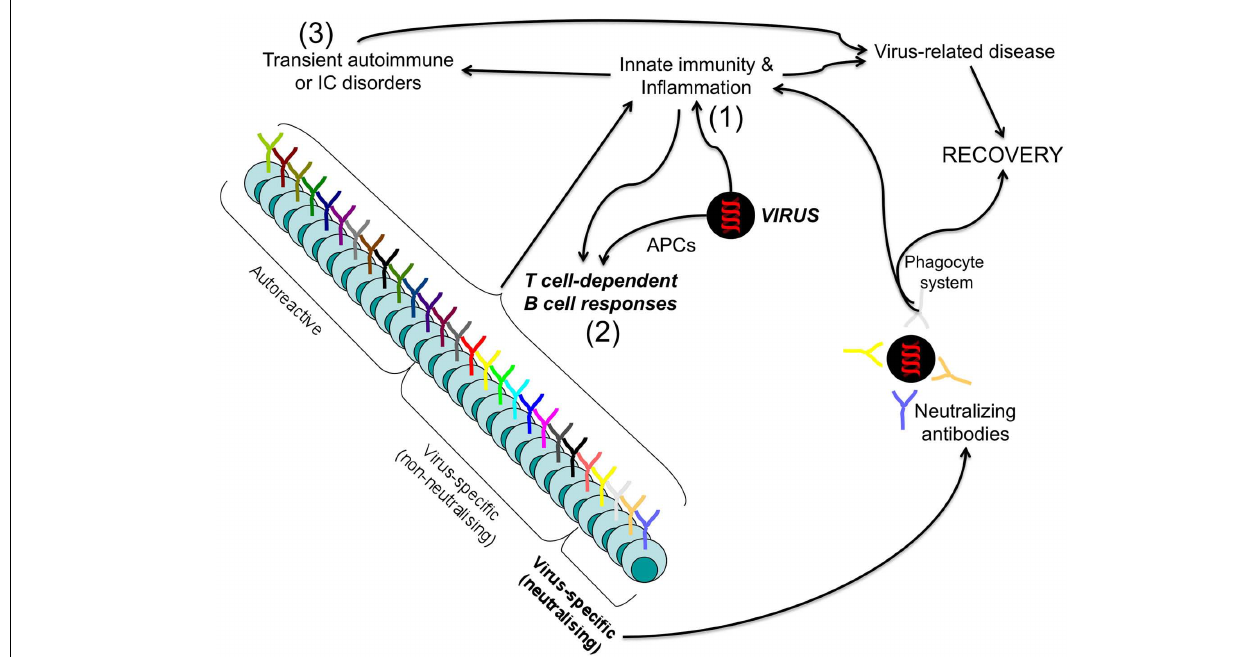
immune complexes (ICs) and produce damage through the cooperation with the innate immune system (macrophages, complement factors, inflammatory cytokines ... ) (3). However, neutralizing, non-neutralizing virus-specific B cells, as well as the autoreactive, act in concert to fight the pathogen: the neutralizing in an antigen-specific manner, the non-neutralizing and autoreactive in a bystander manner via the activation of the phagocytic system by ICs resulting in the amplification of the inflammatory responses (acute disease).This inflammatory storm is self-limited, when the pathogen is